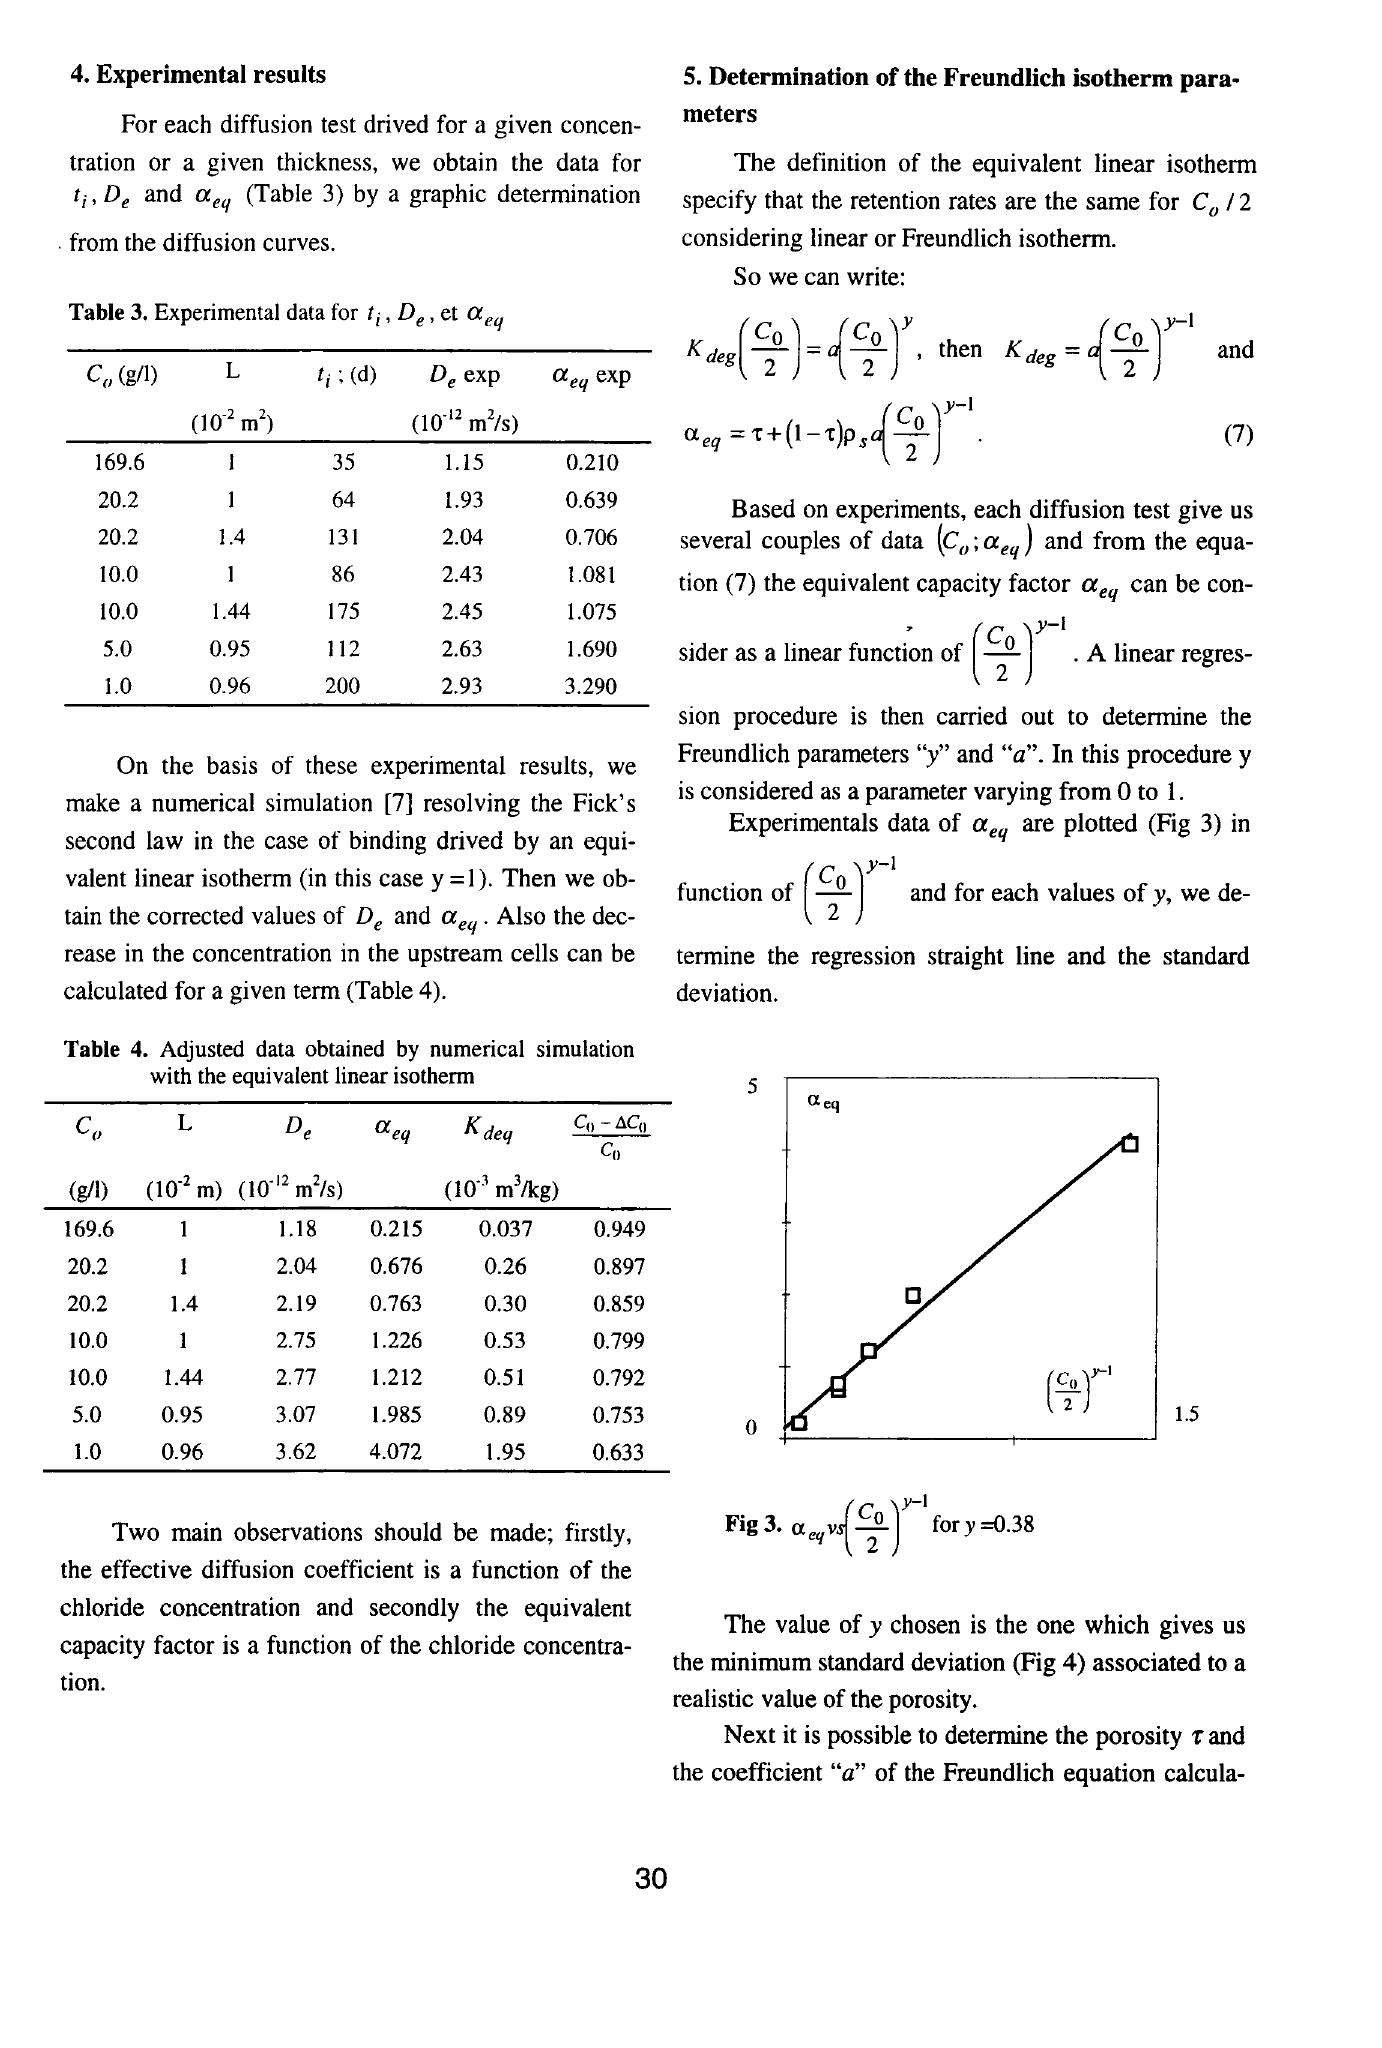
Table 3. Experimental data fort;, De, et aeq